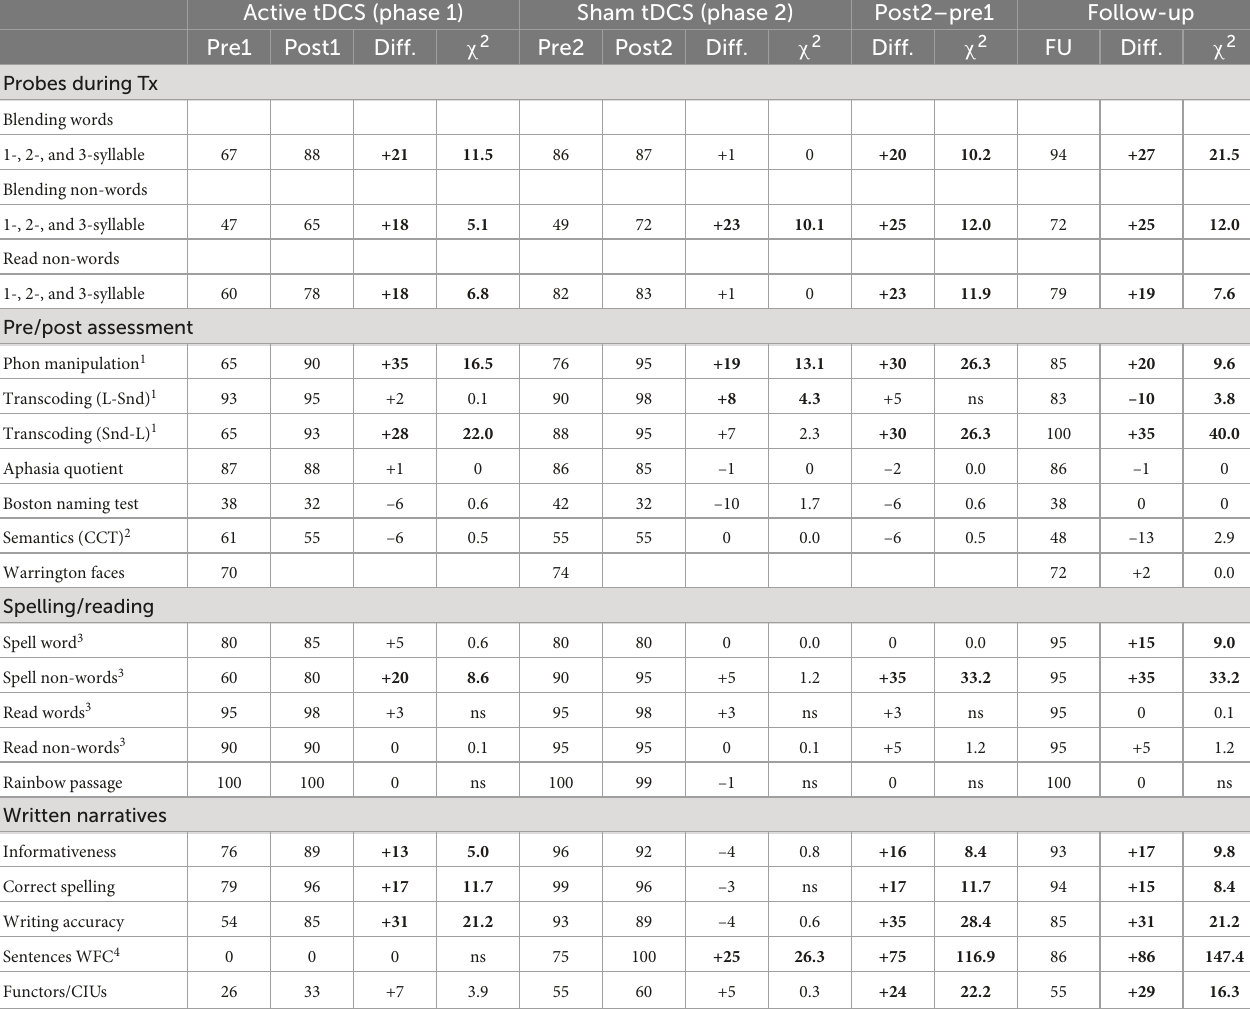
TABLE 2 Percent correct before and after treatment phases with active tDCS and sham tDCS, and at 2-month follow-up testing, with differences